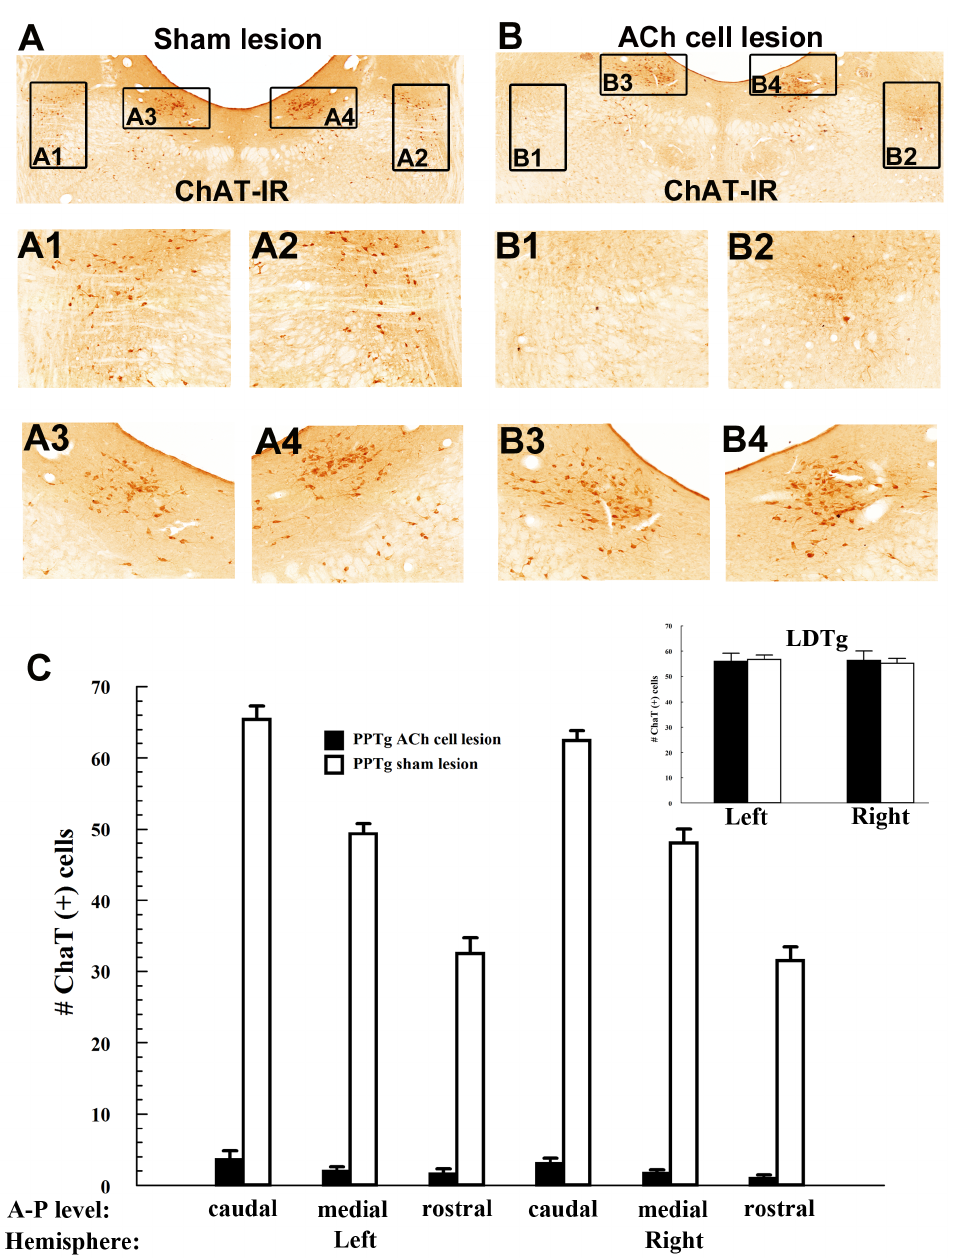
Figure 5. Lesions induced uniform cholinergic cell loss throughout the rostro-caudal extent of the pedunculopontine tegmental nucleus (PPTg). Panels A–B: Low magnification (4X) coronal PPTg sections (A-P -8.3) under bright field microscopy showing ChAT immunoreactive neurons (ChAT-IR; brown cells) following bilateral PPTg infusion of Dtx:UII (B) or vehicle (0.01 M PBS; A) from rats used in behavioral experiments. For better visualization of ChAT immunoreactivity, delimited PPTg areas in (A) and (B) are shown at higher magnification (20X) in A1 and A2 and B1 and B2, respectively. Similarly, delimited LDTg areas in (A) and (B) are shown in A3 and A4 and B3 and B4, respectively. Panel C: Numbers of ChAT-IR cells counted in each of two hemispheres at each of three rostro-caudal PPTg levels (A/P -8.3 caudal, A/P 2 7.7 medial and A/P 2 6.8 rostral) following cholinergic cell lesions (white bars; n=14) or sham lesions (black bars; n=13). Cholinergic cell loss was confined to the PPTg, as the number of ChAT immunoreactive neurons cells in the LDTg was not significantly changed (panel C, inset). Error bars represent 6